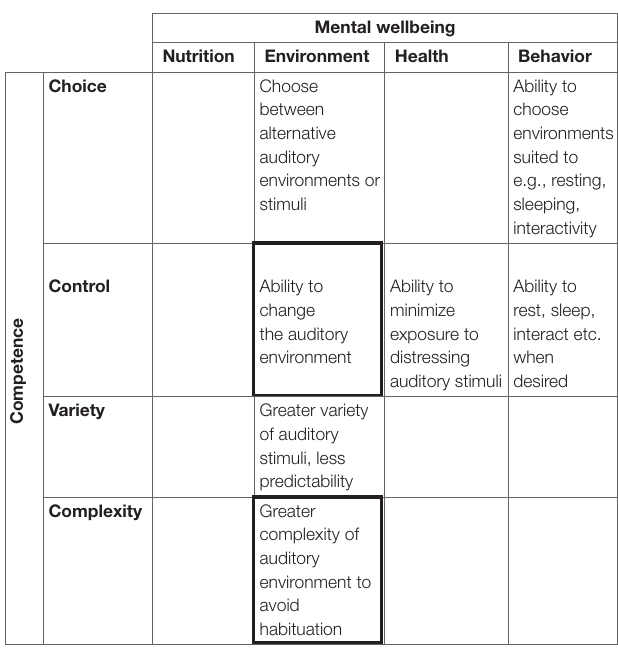
TABLE 4 | WtC design opportunities matrix used to identify opportunities for improving pet dogs’ sound